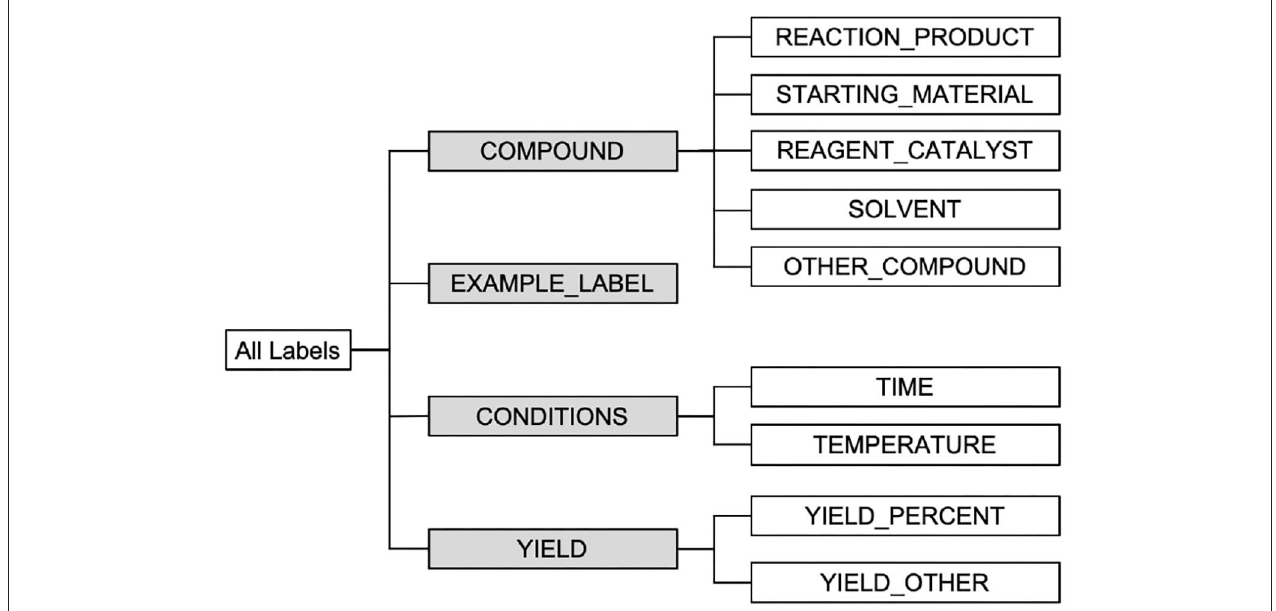
FIGURE 7 | Illustration of the hierarchical NER class structure used in